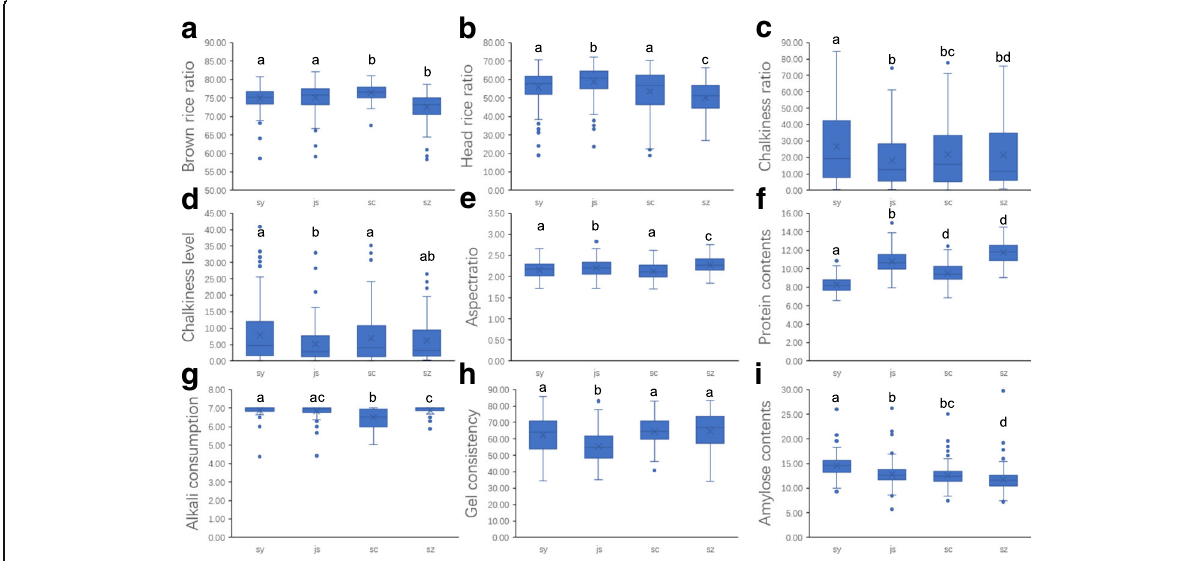
Fig. 2 The box-plot graph of the rice quality traits of RILs in four cultivated areas. a brown rice ratio, b head rice ratio, c chalkiness rice ratio, d chalkiness level, e grain length/grain width, f protein content, g alkali consumption, h gel consistency, and i amylose content. Letter difference means significant at 5% probability levels by Duncan ’ s new multiple range